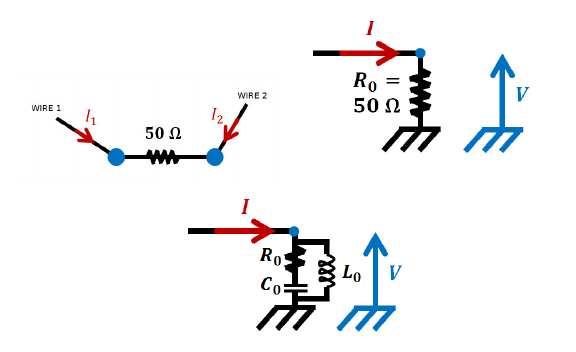
FIGURE 5: Junction circuit models used in the Figure 1 multiple cavity test-case. The figure displays the voltages and currents to be linked to the MTLN voltages and currents.